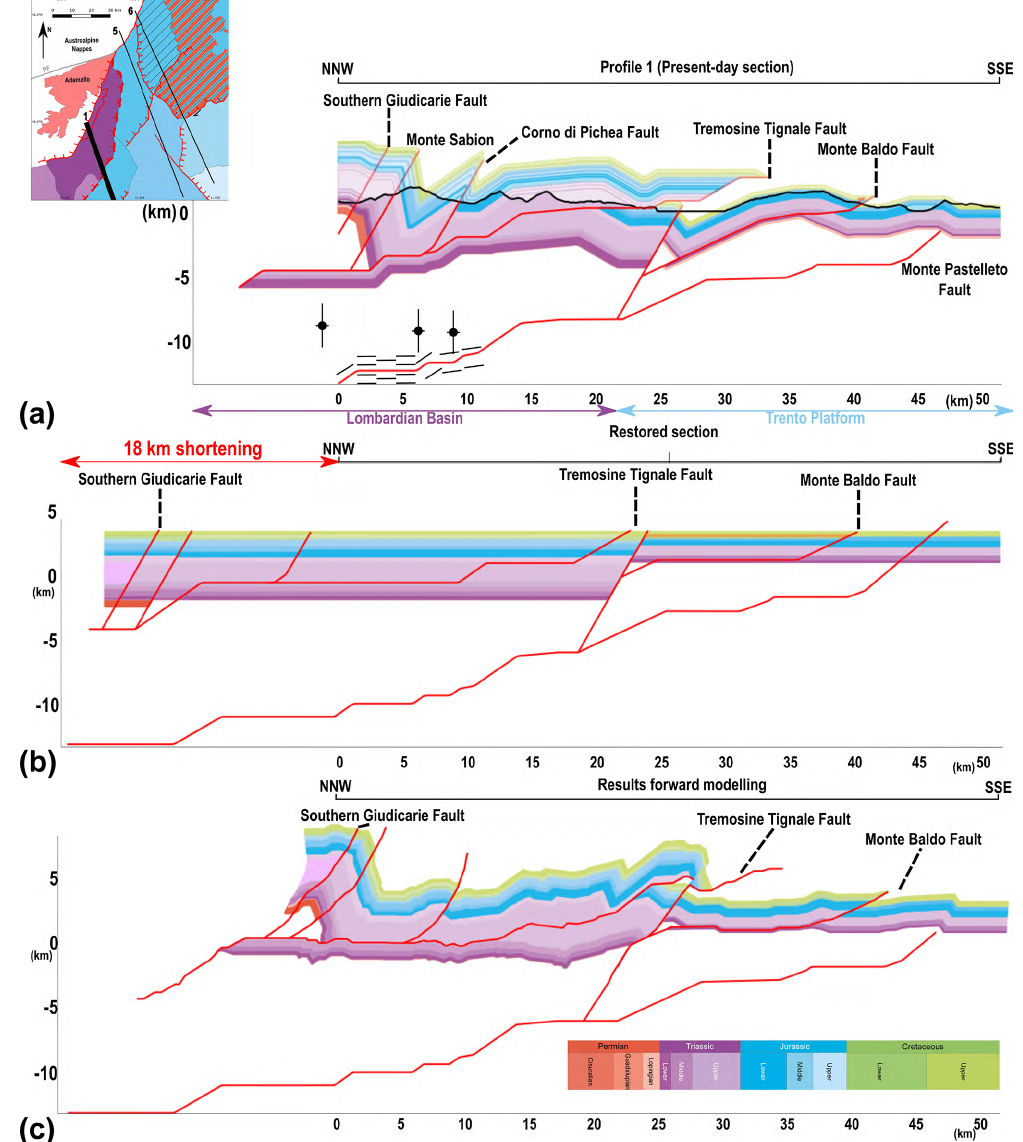
Figure 7. (a) Profile 1 across the Lombardian Basin and Trento Platform. (b) Profile 1 retro-deformed to a layer-cake stratigraphy. (c) Results of forward modelling. Colours in the legend are modified following the International Chronostratigraphic Chart, with the pre-Permian base- ment beneath in white. Black dots indicate earthquake hypocentres during 2017–2018 (SWATH-D Network; Jozi Najafabadi et al., 2021; vertical bars indicate the average error range on hypocentre depths), projected from a swath covering 6km on either side of the profile. Dashed black lines below ∼ 10km indicate ductile